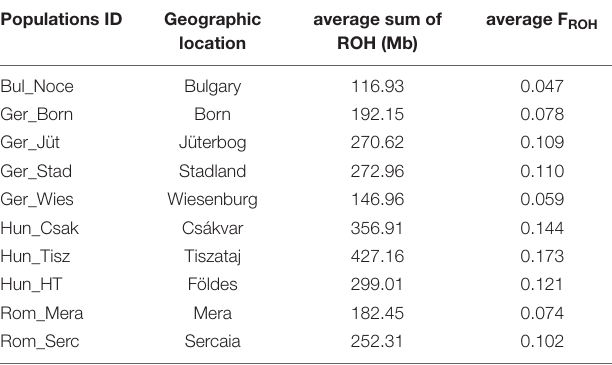
TABLE 4 | Averages of individuals ROH in the genome and coefficient of F ROH per population.